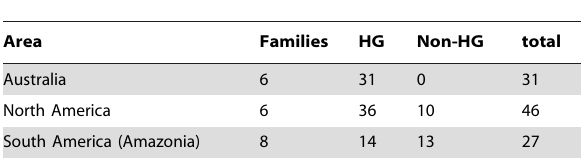
Table 1. Summary of languages by survey